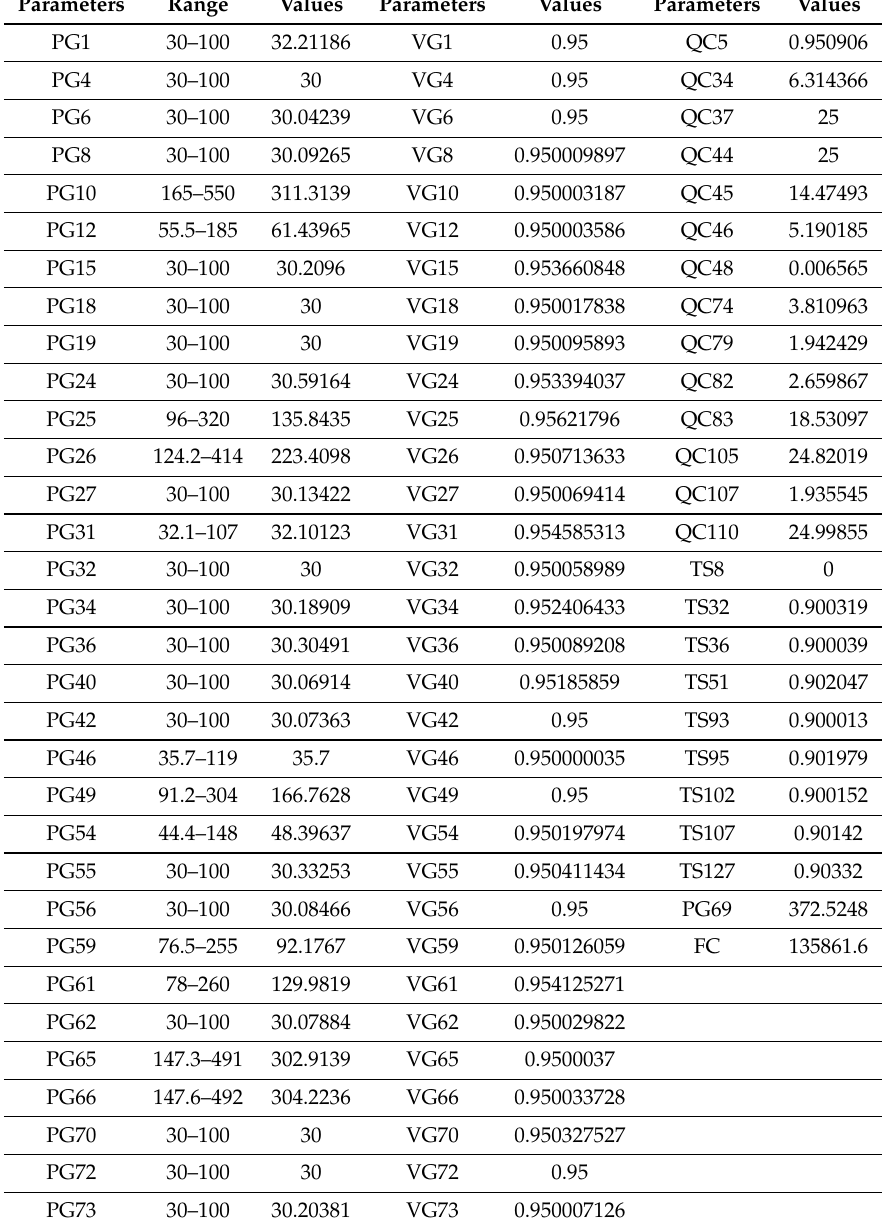
Table 14. Optimal solution obtained by GROM for IEEE 118-bus